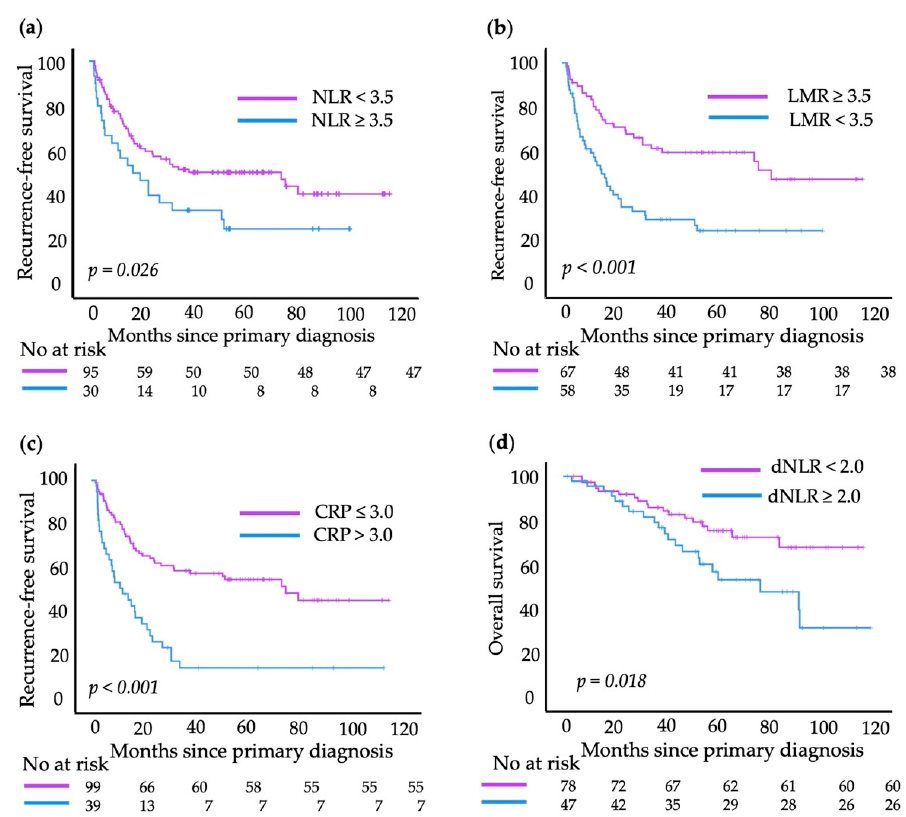
Figure 5. Kaplan–Meier survival curves showing recurrence-free survival (RFS) and overall survival (OS) for dichotomized blood values: ( a ) neutrophil-to-lymphocyte ratio (NLR); ( b ) lymphocyte-to- monocyte ratio (LMR); ( c ) C-reactive protein (CRP); ( d ) derived NLR (dNLR). The log-rank test was used to compare between groups; p < 0.05 was considered significant.